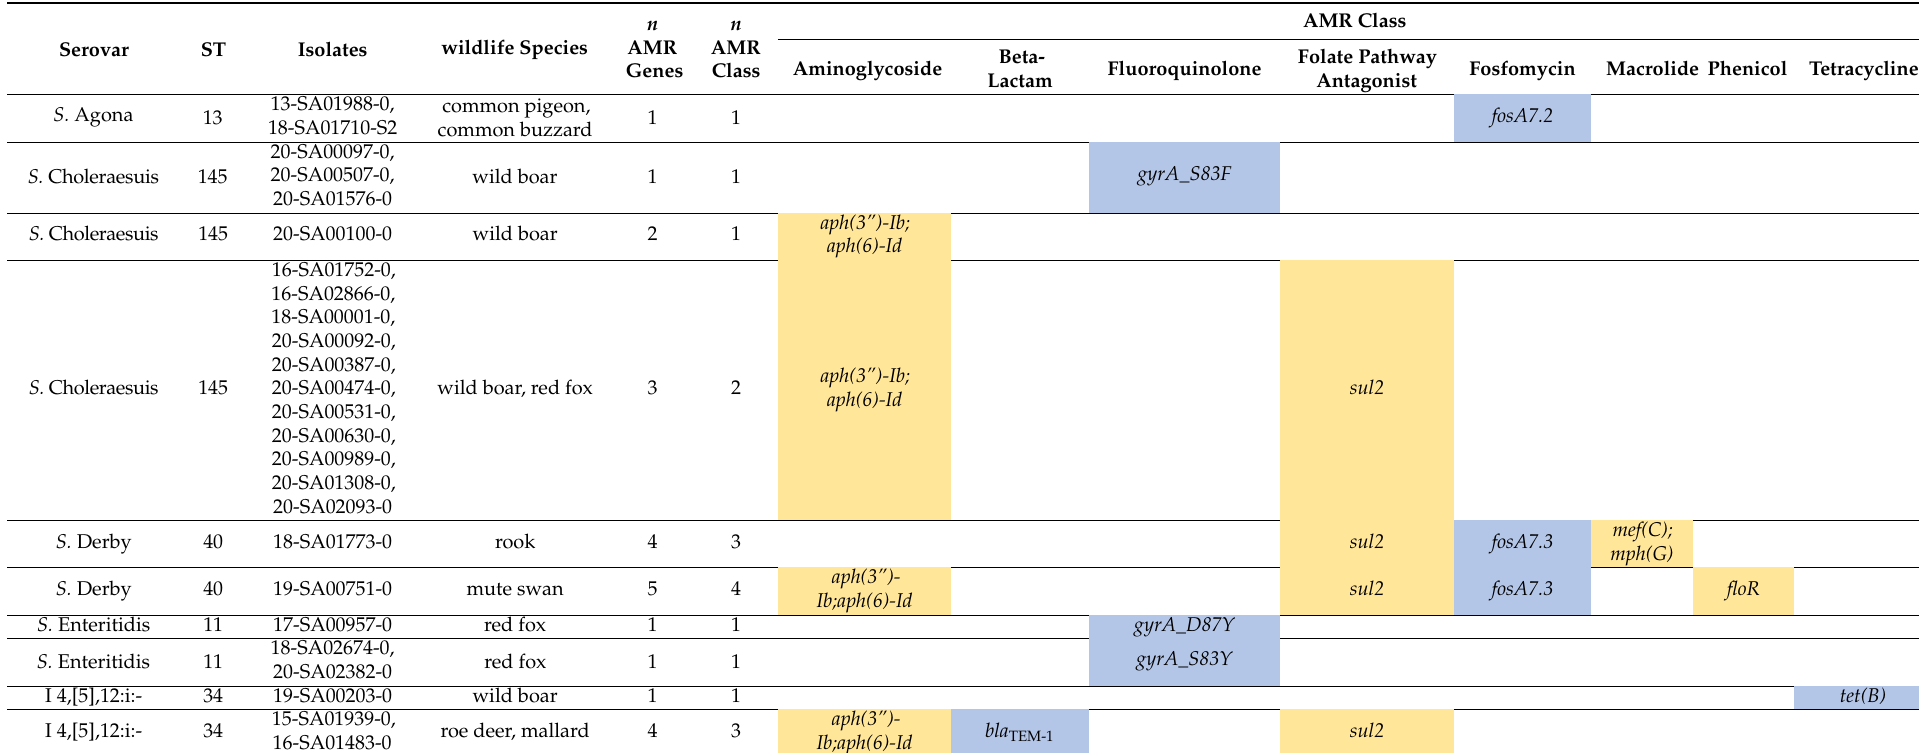
Table 1. Overview of AMR genes detected from the sequence data of the Salmonella enterica wildlife isolates investigated in this